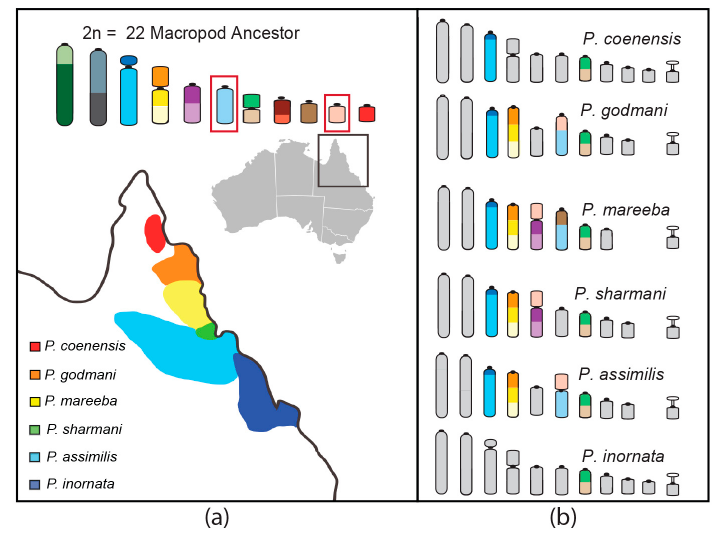
Figure 4. Karyotypic variation amongst six parapatric Petrogale species in Queensland. ( a ) The geographic distribution of the six species (adapted from [101]). ( b ) The differences from the ancestral macropod karyotype are highlighted to demonstrate the frequent involvement of ancestral chromosomes 6 and 10 in rearrangements among these